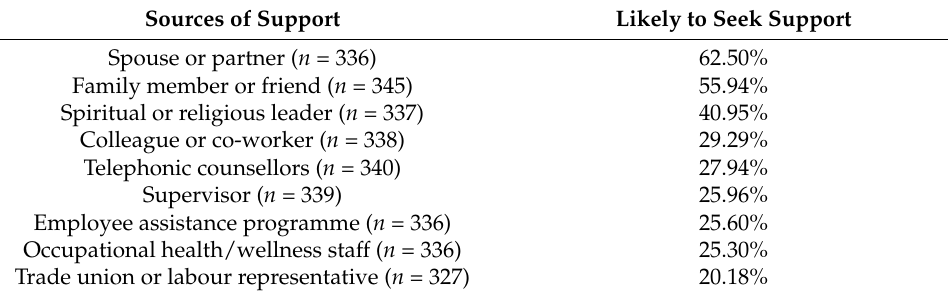
Table 4. Descriptive results for preferred sources of support ( n = 388).